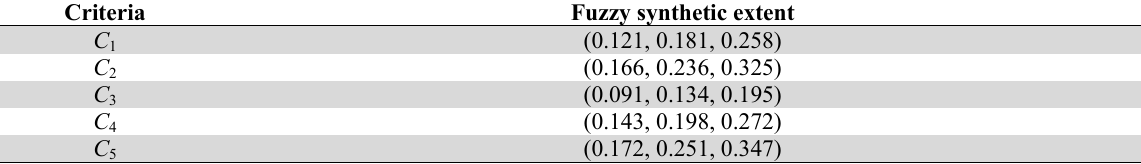
Fuzzy synthetic extent values of lecturers’ research productivity evaluation criteria Criteria